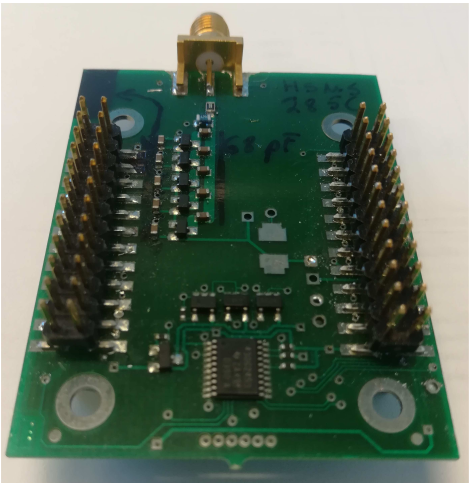
Figure 10. A prototype of energy harvesting printed circuit board.